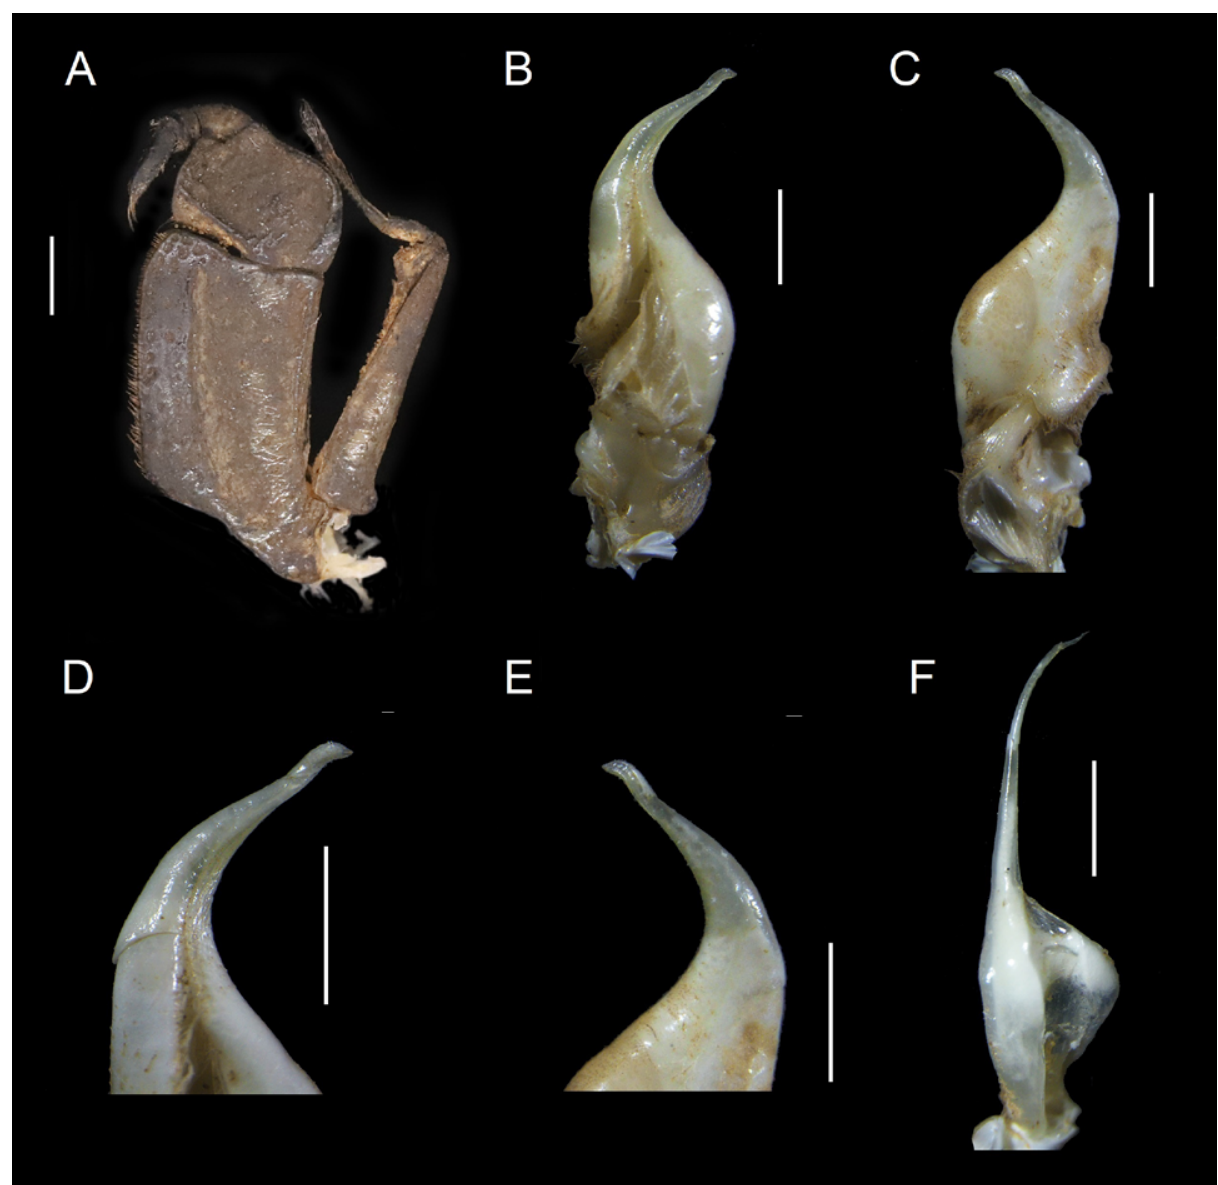
Figure 2. Mekhongthelphusa menglongensis sp. nov., holotype male (35.1 × 30.4 mm) (NNU 16C-MM01). A , Third maxilliped; B , G1 ventral view; C , G1 dorsal view; D , G1 terminal segment ventral view; E , G1 terminal segment dorsal view; F , G2. Scale bars = 1